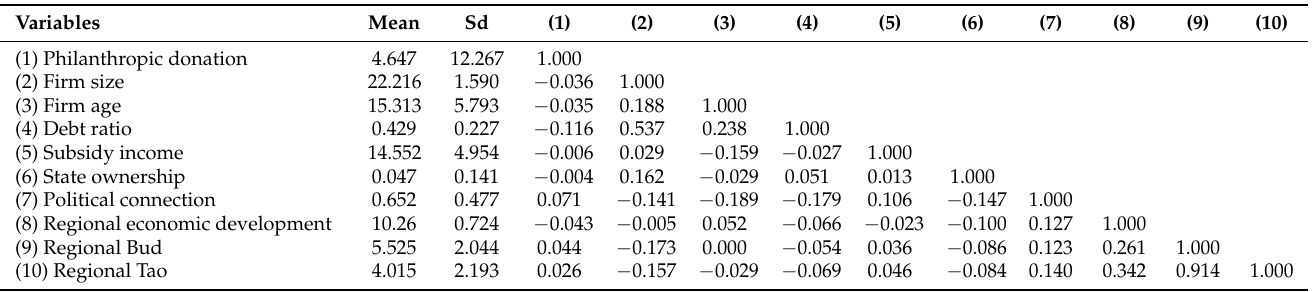
Table 1. Descriptive statistics and correlation for donation dimension.